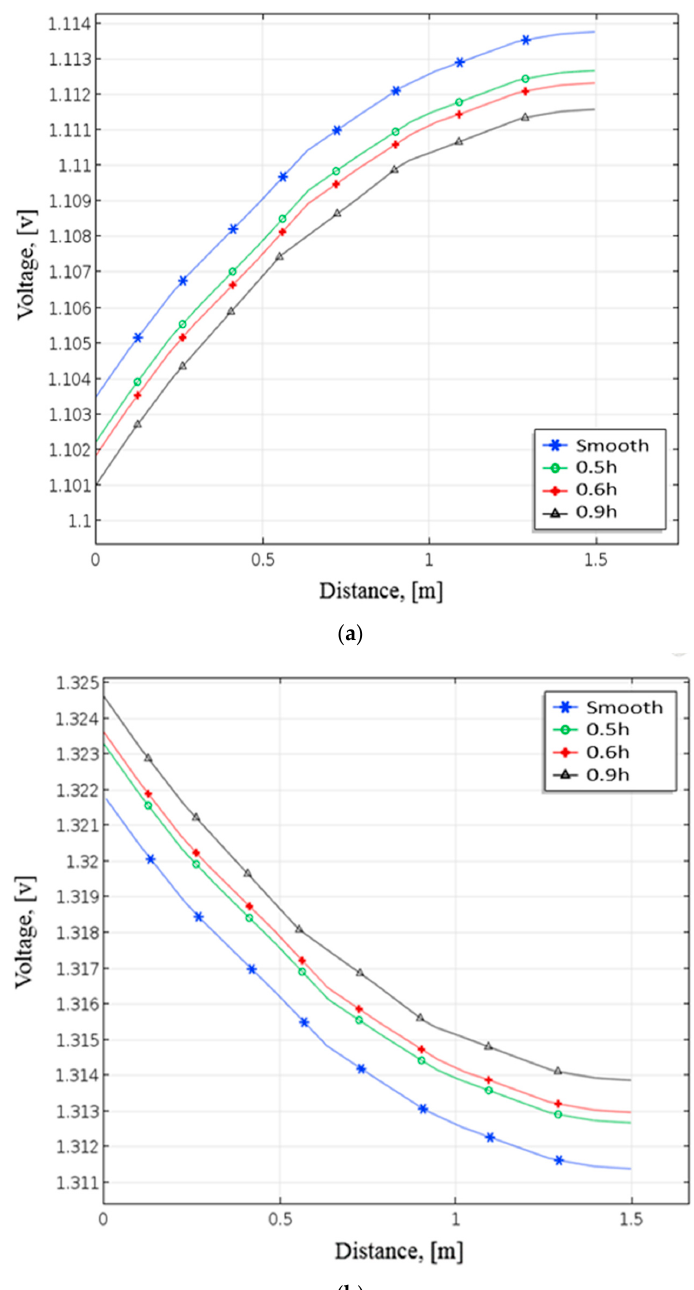
Figure 8. Distribution of terminal voltage at positive electrode under different heights of baffle during ( a ) discharging and ( b ) charging from numerical analysis. Voltage comes to 1.101 V when the height of the baffles is at 0.9 h and drops to roughly 2.5 mV. Figure 8b demonstrates that the terminal voltage with the smooth channel is about 1.3218 V near the positive electrode side. When the baffle height increases, the terminal voltage increases. The terminal voltage increased by about 1.5 mV compared with the smooth channel while setting the height at 0.5 h. When the baffles were at 0.9 h, the terminal voltage increased to 1.3245 V. These results indicate that the terminal voltage rises with raising the height of the baffles. As a result, the performance can improve by raising the baffle height. This research employs the baffle height of 0.9 h for all simulation